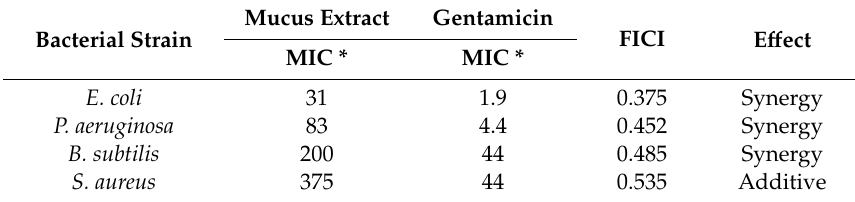
Table 2. FICI determination of P. sophore mucus